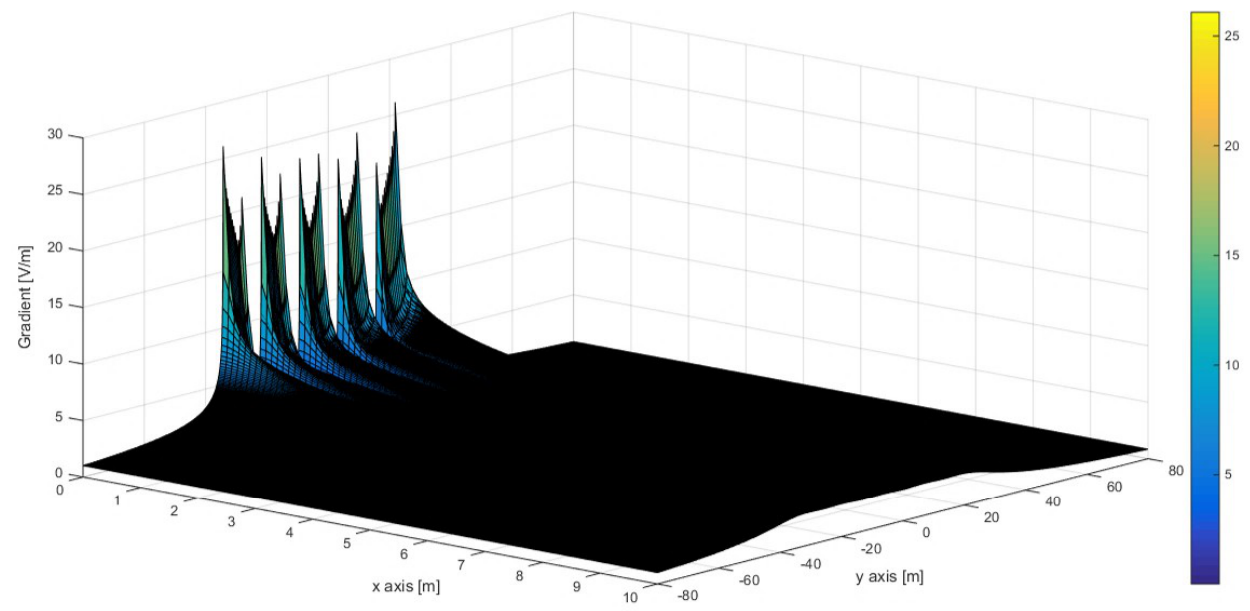
Figure 23. Electric field strength for method “C”, of linear current source, for an electrode station of 6 linear frames in a row with d frames = 6.50 m; each frame consists of 13 electrodes of active length L = 2.13 m, D el = 0.50 m, ρ w = 0.25 Ω · m, θ = 248 ◦ (area of Korakia), J full_load_steady = 22 A/m 2 (steady state and operation of 5 frames, except no. 6).